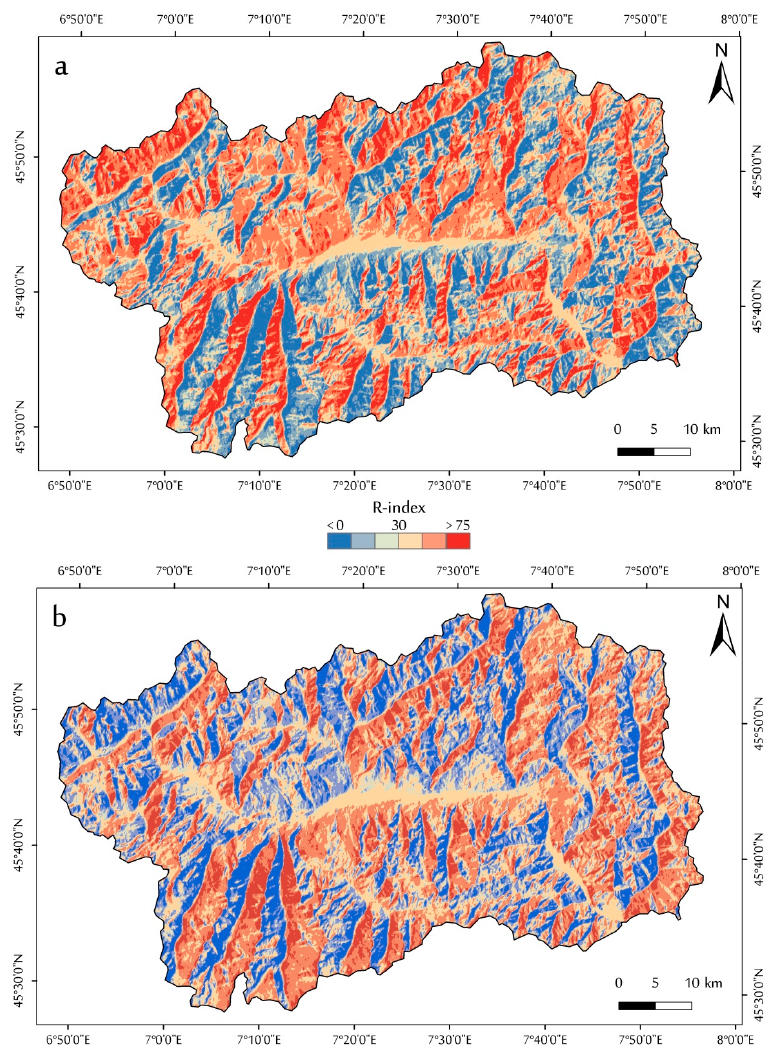
Figure 2. R-Index map ( a ) of the ascending orbit and ( b ) of the descending orbit for the VDA region. Layover/foreshortening cases are present for values lower than zero ( blue portion).